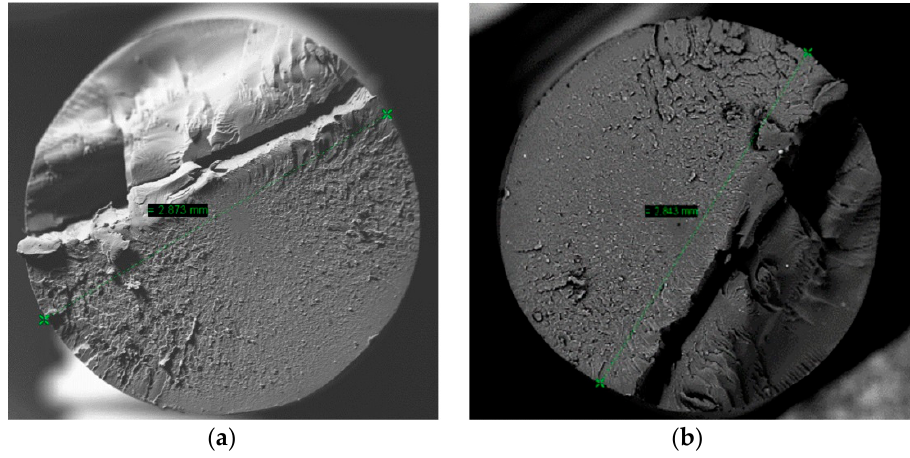
Figure 2. Filament sections in different zones. ( a ) Diagonal Measure 1 ( b ) Diagonal Measure